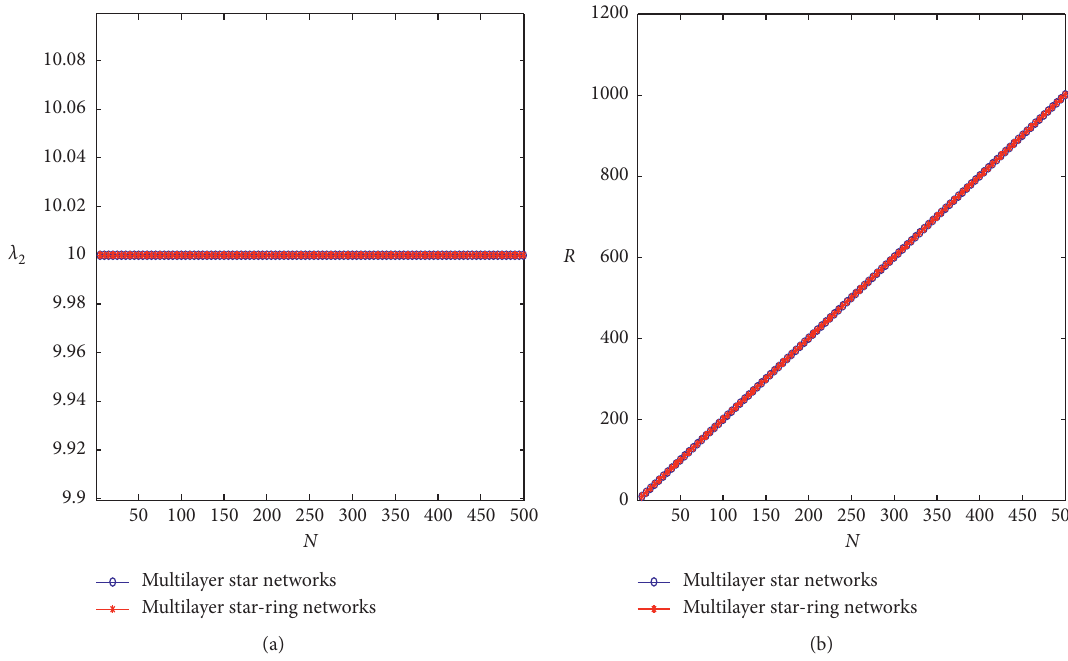
Figure 17: The synchronizability of multilayer star and star-ring networks, where a � 20, d � 1, M � 10, and a > Md . (a) λ varying N for multilayer star and star-ring networks. (b) R with respect to varying N for multilayer star and star-ring